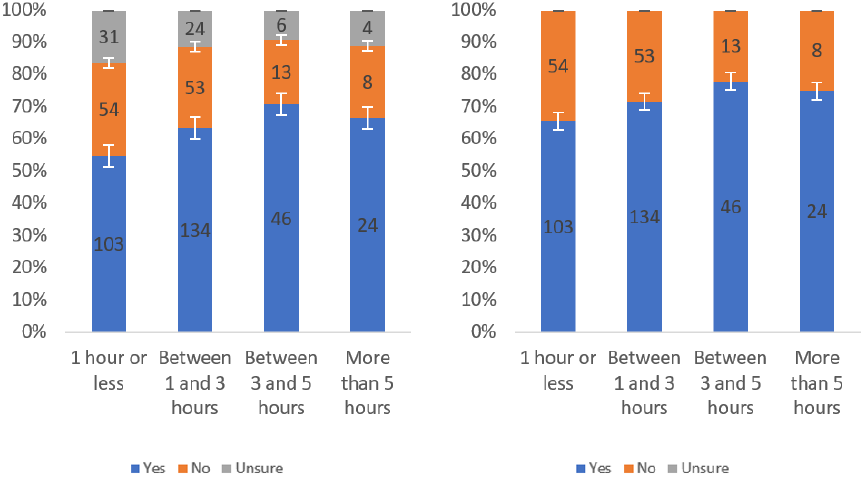
Figure 31. Responses regarding respondents’ willingness to review by internet usage level including ( left ) and excluding ( right ) unsure responses.